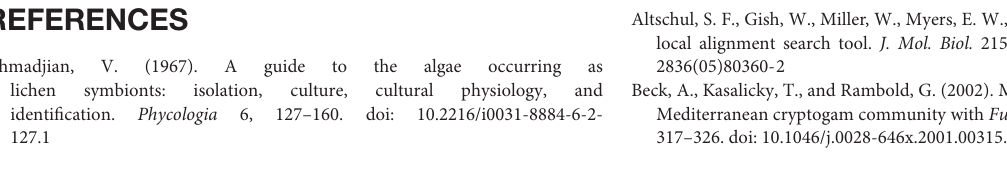
Supplementary Figure 1 | Phylogenetic hypothesis based on the ITS locus of Trebouxia Clade “I”: the 50% majority rule consensus tree of the Bayesian analysis is presented; ML bootstrap values higher than 70% are reported with bold branches; Bayesian PP values > 0.8 are reported above branches. DNA extraction numbers of the new Trebouxia sequences coming from the original lichen thalli are in italics , while those obtained from the cultured strains are in bold. Correspondence between the original lichen thallus and the axenically isolated Trebouxia strains is indicated by an asterisk and a number in parenthesis ( ∗ 1–64; as in Supplementary Table 2 ). Sequences coming from either lichen species are color coded: green for Rhizoplaca melanophthalma and black for Tephromela atra . Polyphyletic species-level lineage I01 is identified according to Muggia et al. (2020). Supplementary Figure 2 | Phylogenetic hypothesis based on the ITS locus of Trebouxia Clade “S”: the 50% majority rule consensus tree of the Bayesian analysis is presented; ML bootstrap values higher than 70% are reported with bold branches, and Bayesian PP values > 0.8 are reported above branches. DNA extraction numbers of the new Trebouxia sequences coming from the original lichen thalli are in italics , while those obtained from the cultured strains are in bold. Correspondence between the original lichen thallus and the corresponding axenically isolated Trebouxia strains is indicated by an asterisk and a number in parenthesis ( ∗ 1–64; as in Supplementary Table 2 ). Sequences coming from either lichen species are color coded: green for Rhizoplaca melanophthalma and black for Tephromela atra . Polyphyletic species-level lineage S02 is identified according to Muggia et al. (2020). Supplementary Table 1 | Trebouxia sequences retrieved from GenBank and included in the phylogenetic analyses of Figure 1 and Supplementary Figures 1 , 2 are reported with their OTU ID (according to Muggia et al., 2020) and their NCBI accessions. Supplementary Table 2 | NCBI accession numbers are reported for the ITS sequences of Trebouxia species-level lineage identified directly from